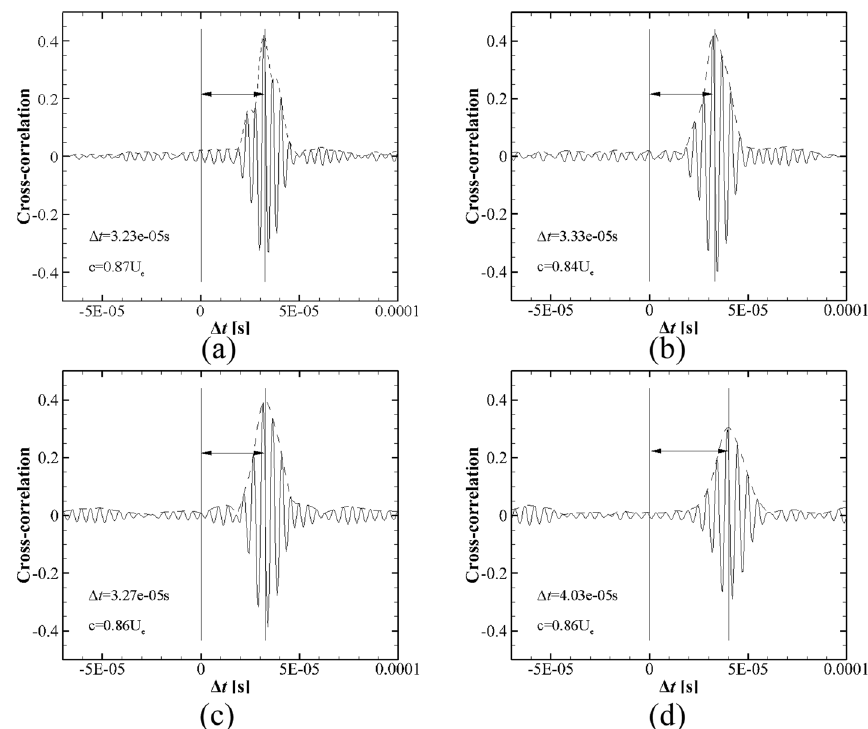
Fig. 9 Group velocity of second mode instability wave package based on bluntness of R NO. 1 NO. 2, b Sensor NO. 2 →